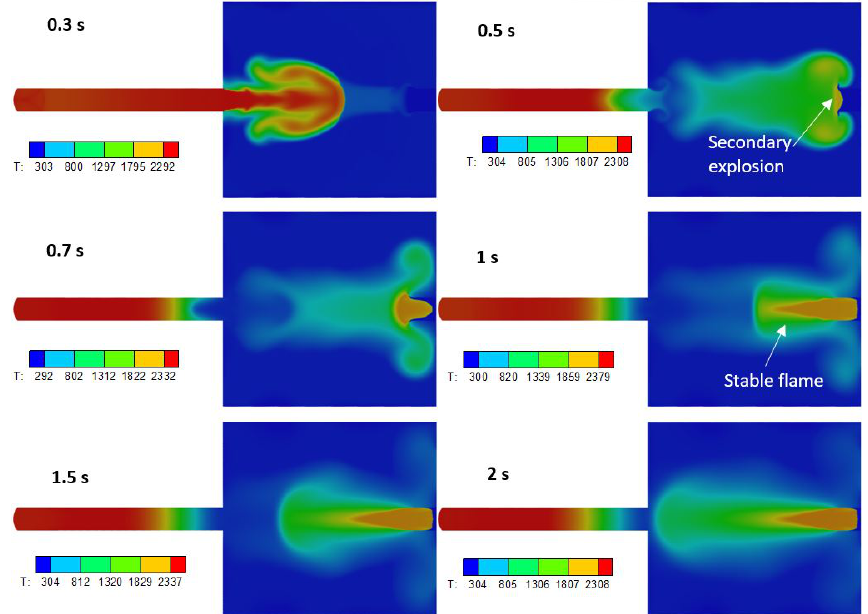
Figure 6. Time series of the contour of temperature for the scenario where explosion occurs (7.5% methane) in the RTO and generates a flame that propagates out towards the evasé.